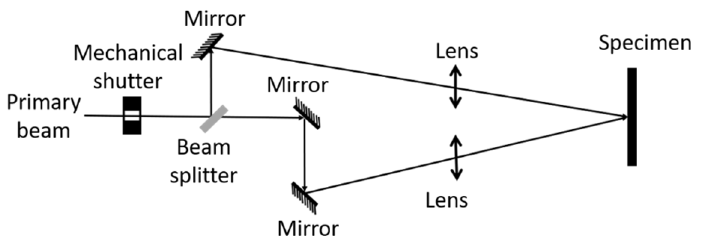
Figure 1. Schematic diagram of the laser-interference system. An angle between the beams of 𝛼 = 12° is used in this study.